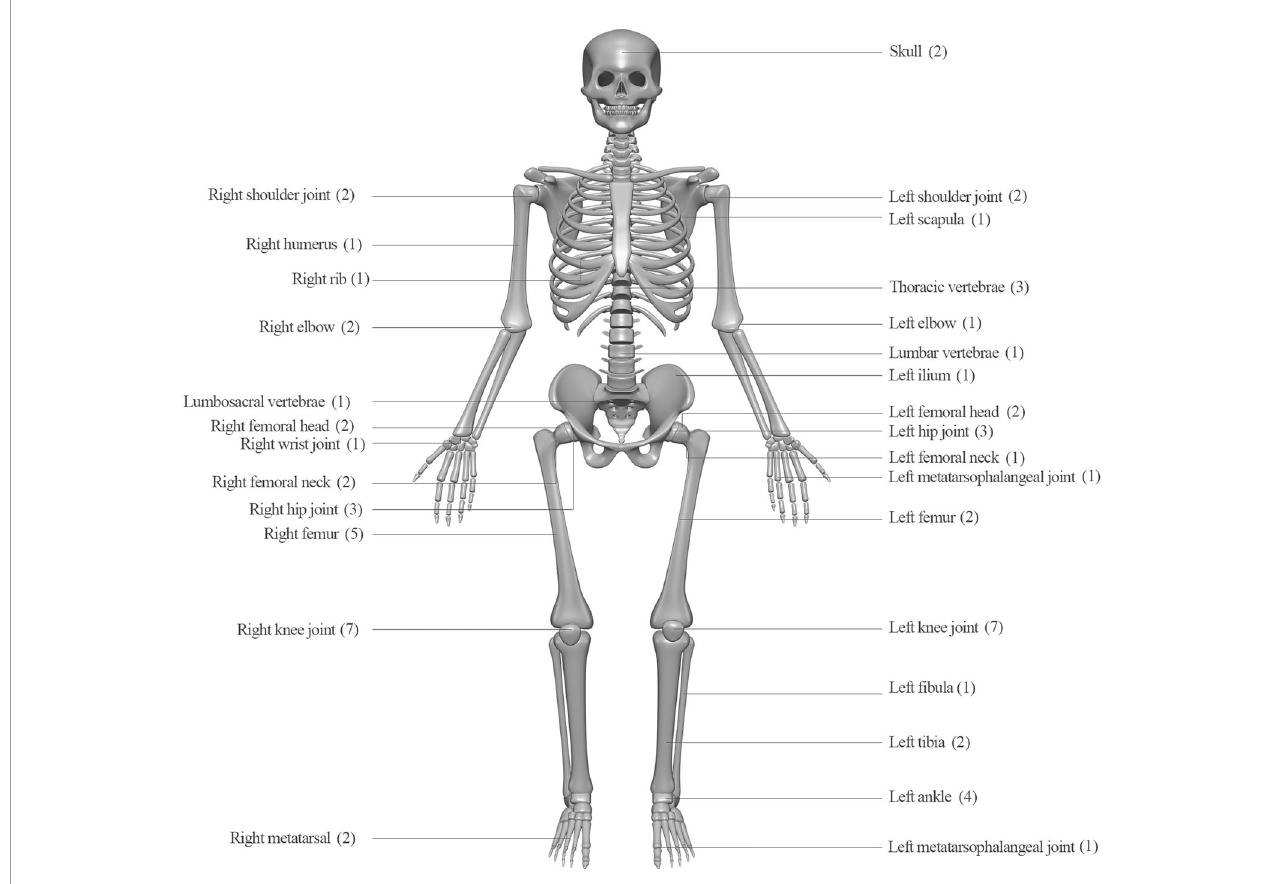
FIGURE 2 | Infection sites and case numbers of 44 patients with melioidotic osteomyelitis and septic